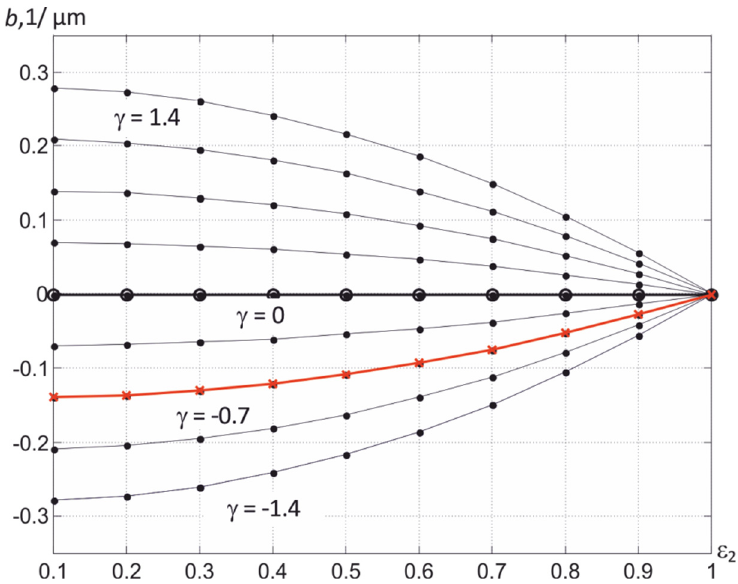
Figure 9. Family of dependences b ( γ , ε 2 ) when using expression (16) and changing γ in the range from minus 1.4 to 1.4 μ m − 1 with a step of 0.35 μ m − 1.